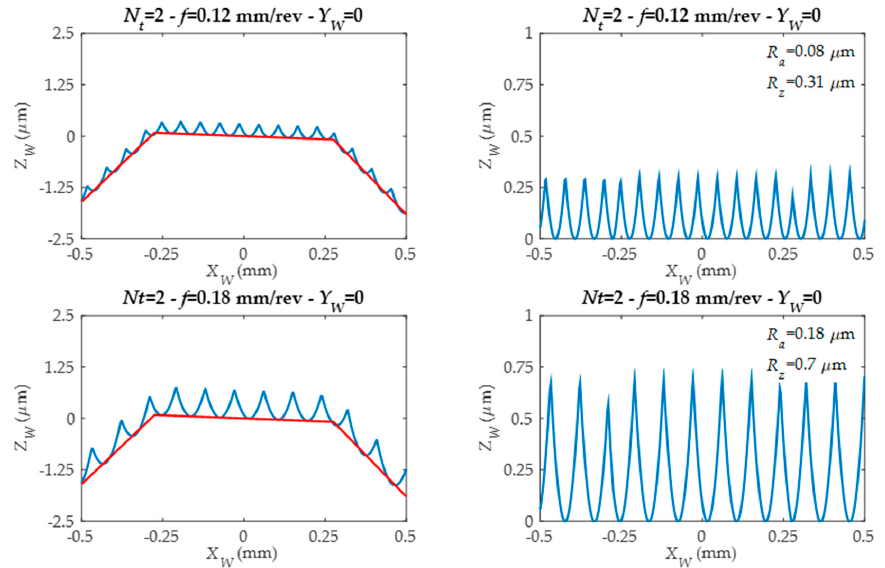
Figure 12. Predicted roughness profiles for different feed values and for the same tool. Table 5. Roughness predicted results for gear